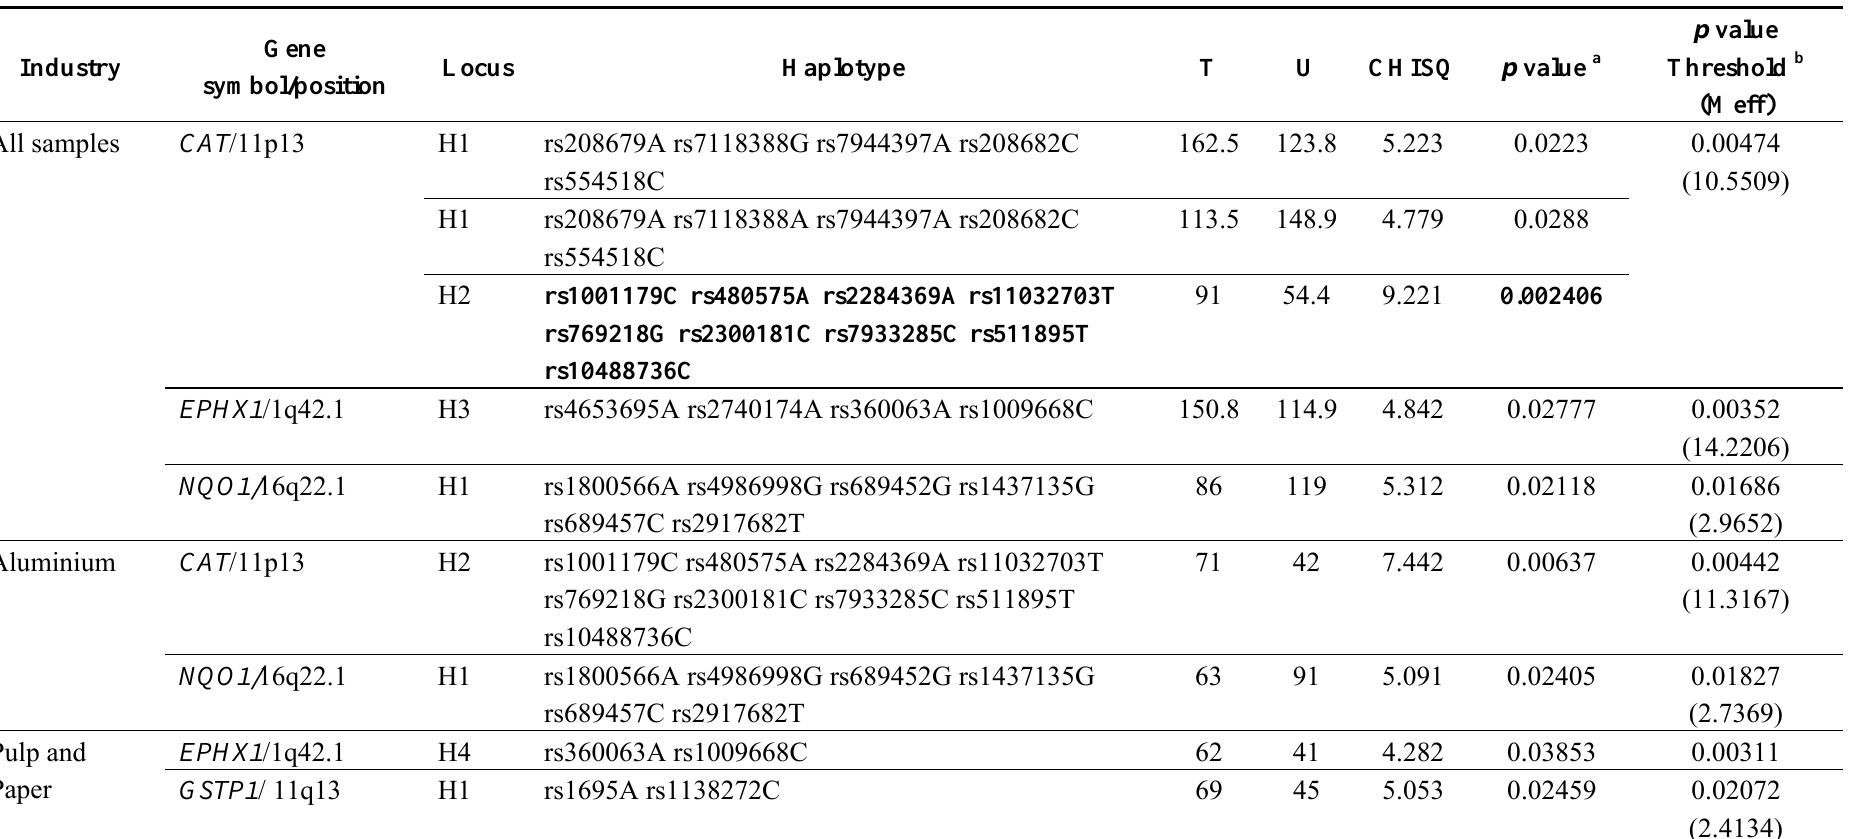
Table 4. Transmission Disequilibrium Test (TDT) results with p value < 0.05 for haplotypes and stratified according to the proximity of aluminium of pulp and paper